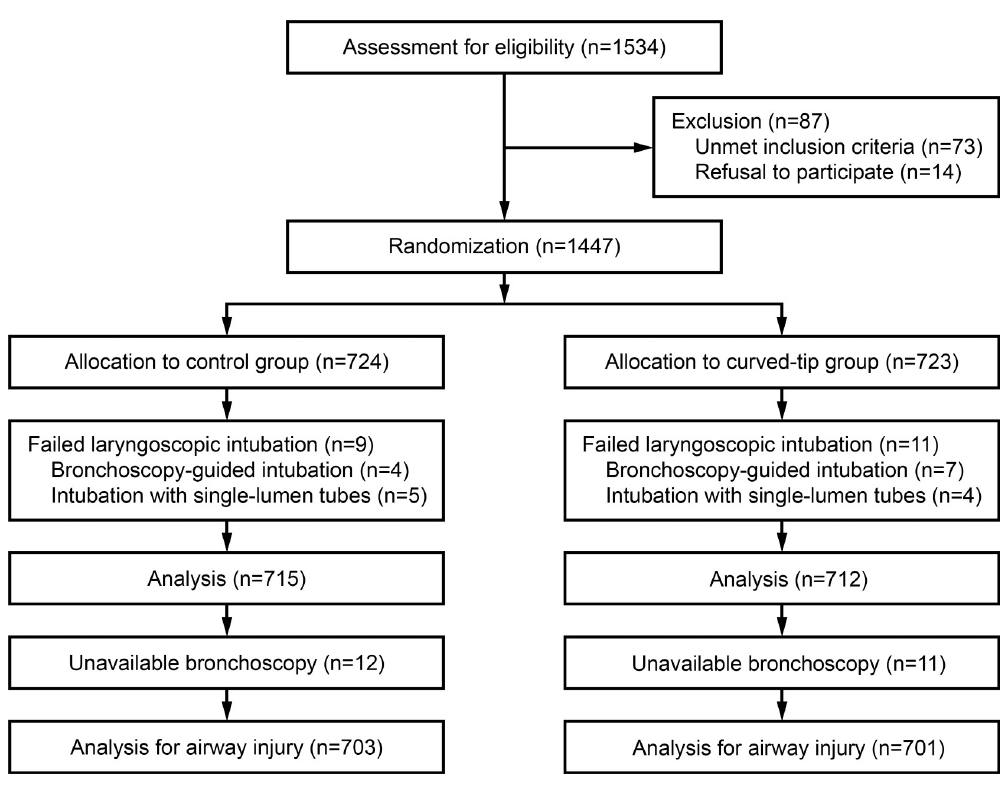
Fig 1. CONSORT flow